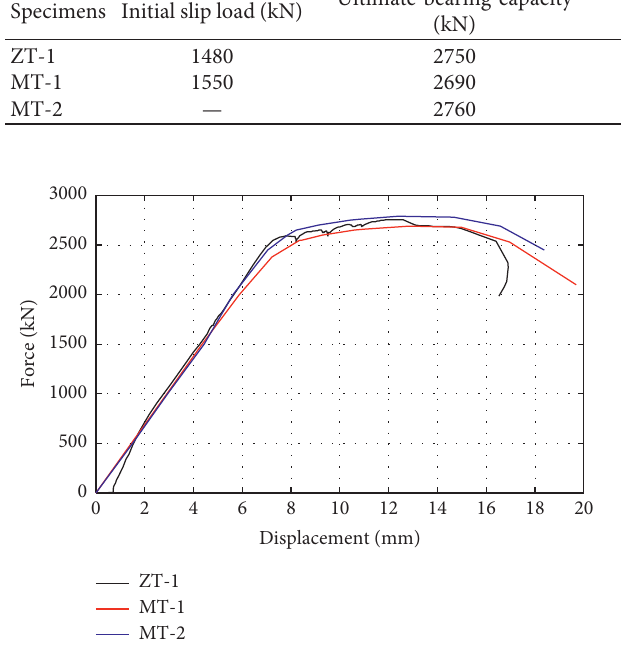
Figure 25: Load-displacement diagram.